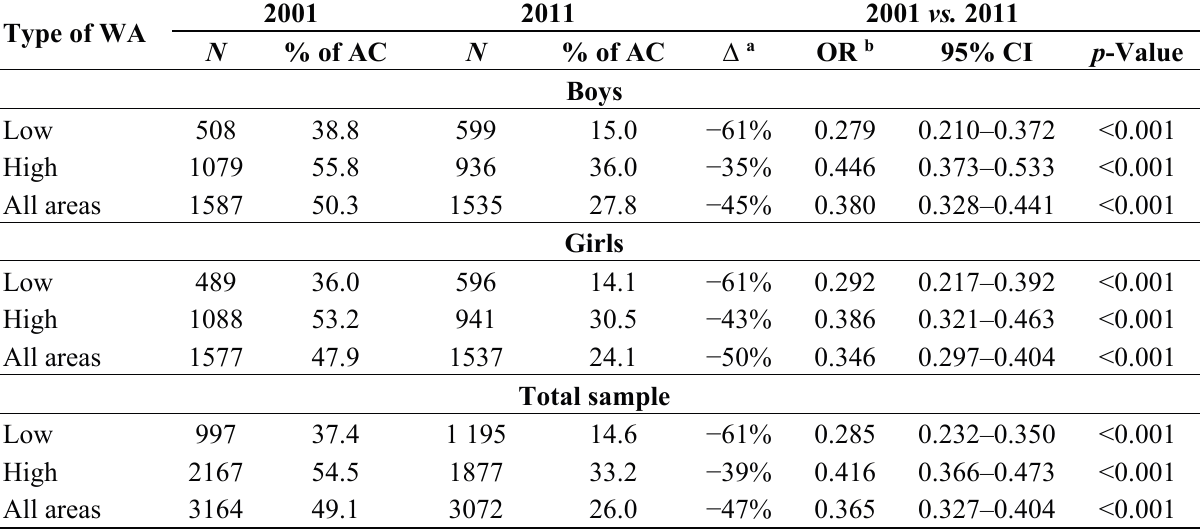
Table 2. Changes in active commuting to school between 2001 and 2011 by sex and type of walkable